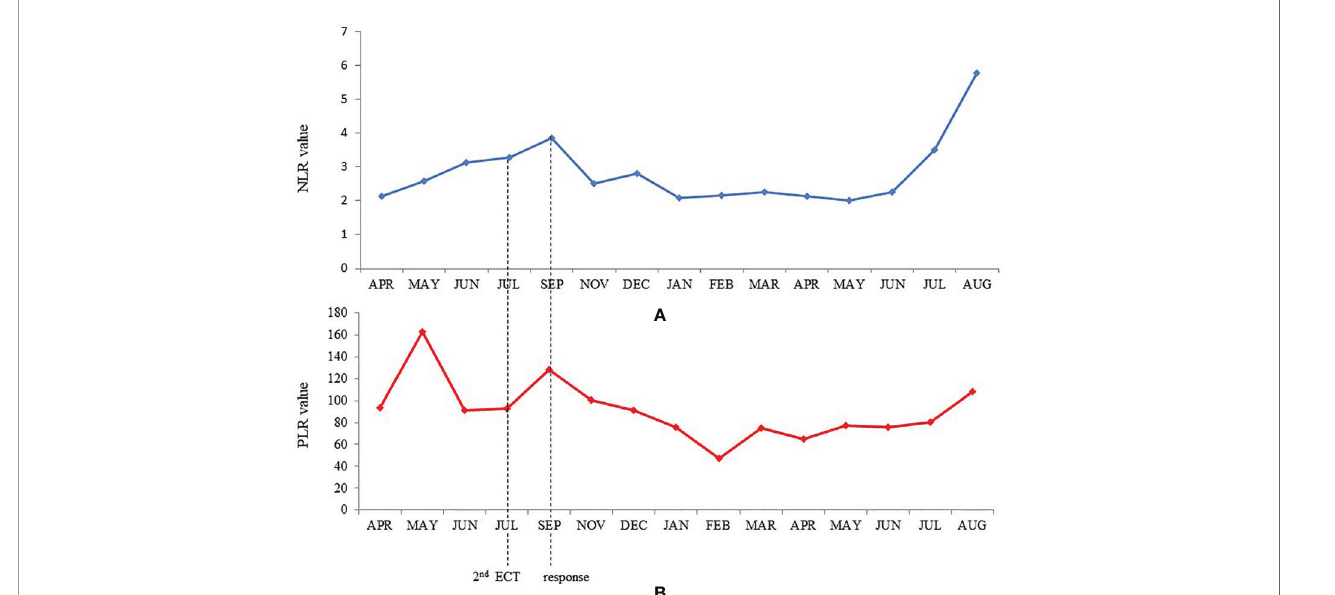
FIGURE 3 | Trends of neutrophil-lymphocyte ratio (A) and platelet-lymphocyte ratio (B) during